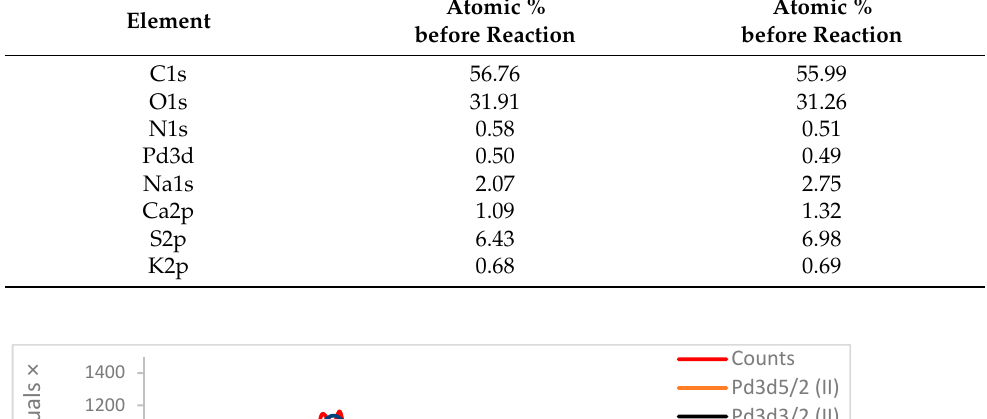
Table 3. Elemental identification and quantification of i -Pd(OAc) 2 (TPPTS) 2 before and after reac- tion, determined by XPS.